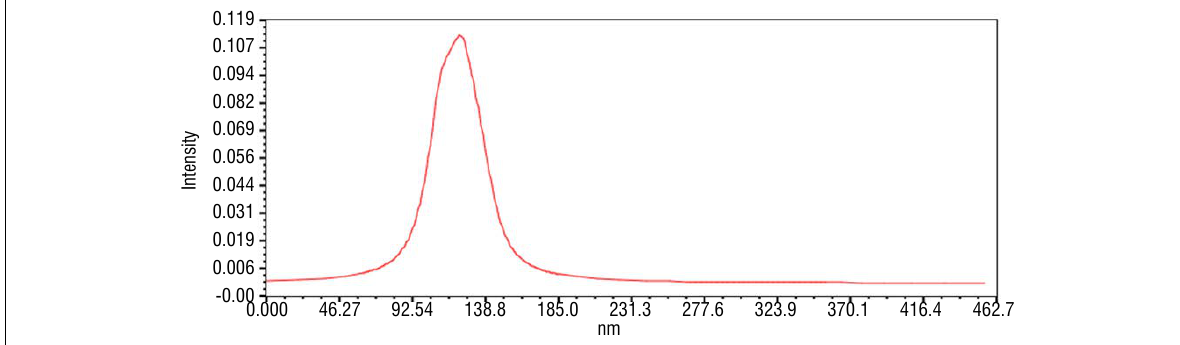
Figure 3: Ultraviolet-visible spectrogram of